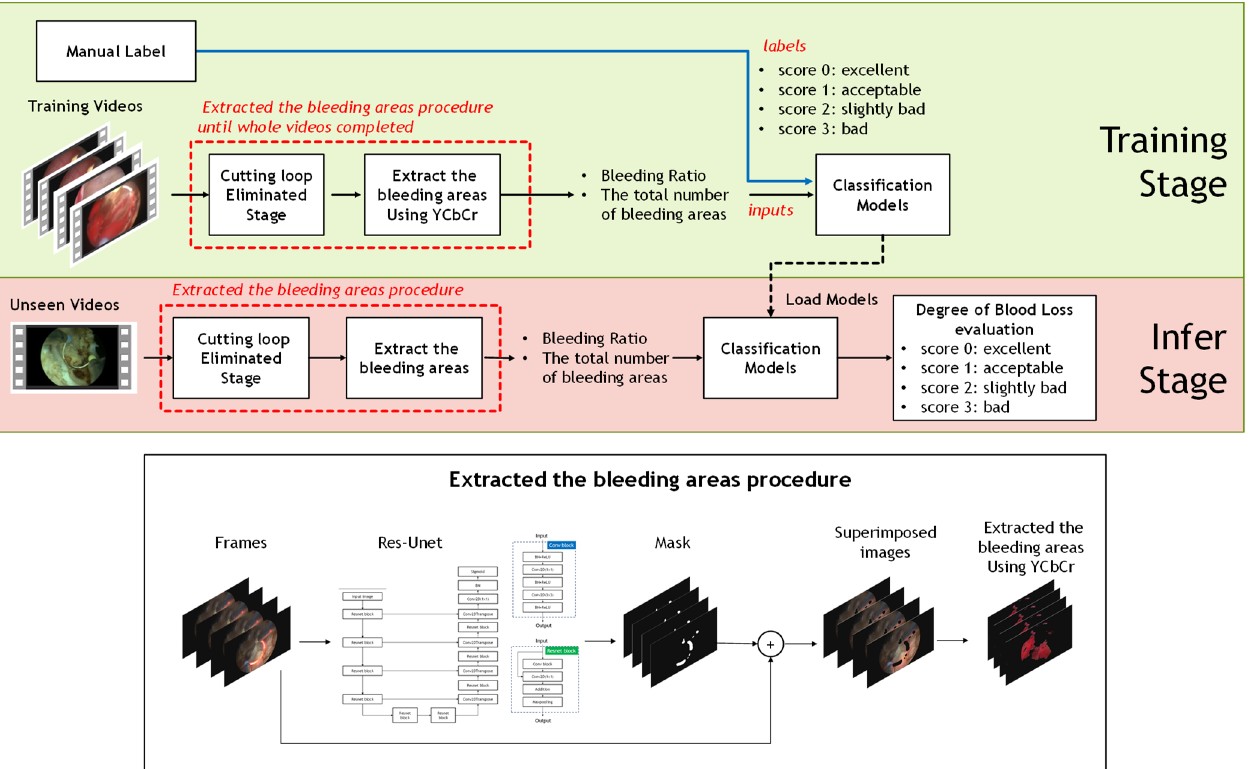
Figure 1. The illustration of the flowchart for ranking the bleeding loss level.